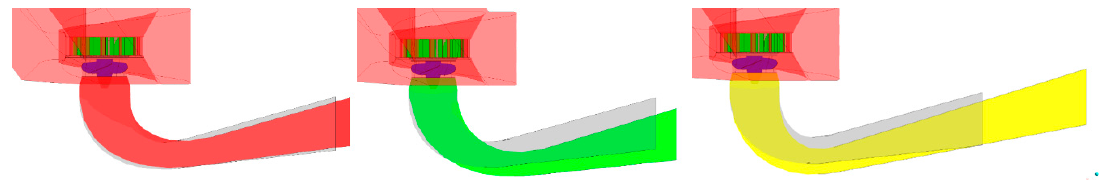
Figure 9. Comparison among geometries in meridional view: Baseline (grey); Candidate 1 (red); Candidate 2 (green); Candidate 3 (yellow).